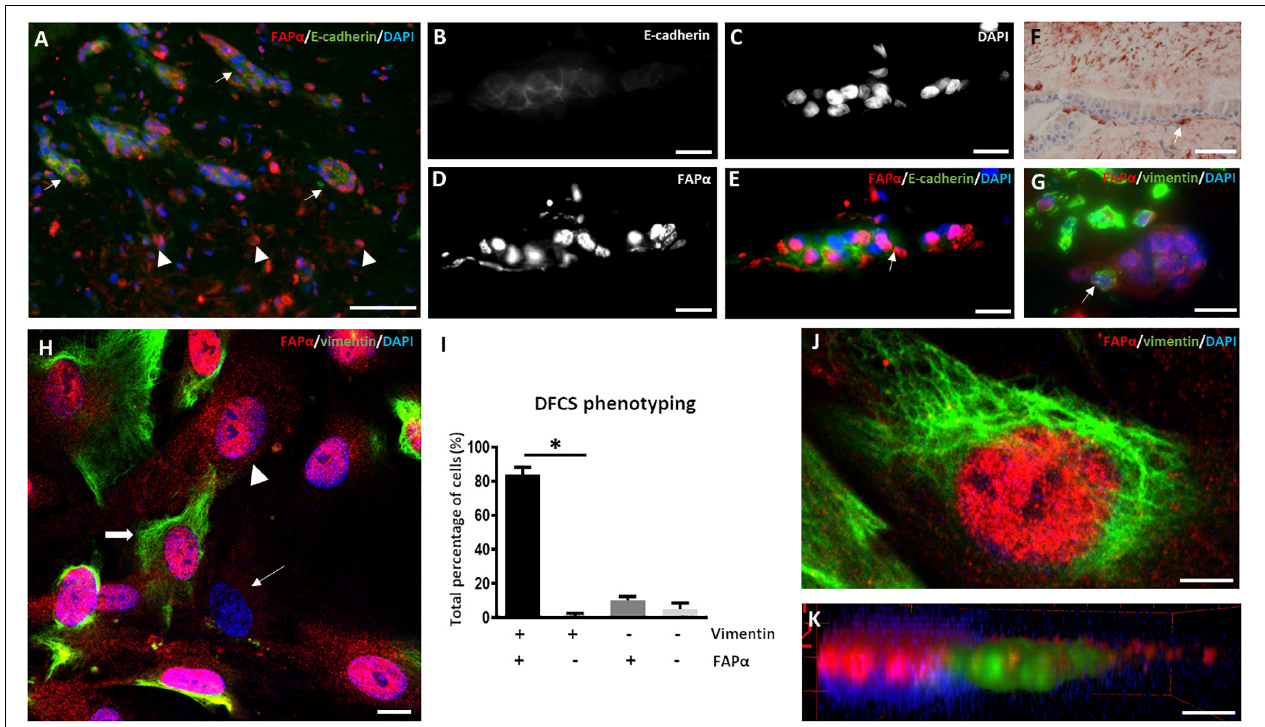
FIGURE 1 | FAP α is expressed in stem cells of the dental follicle. (A) Double immunofluorescent staining in dental follicle tissue of FAP α (red), E-cadherin (green), and the nucleus (DAPI, blue). Arrows indicate epithelial rests and arrowheads point to FAP α + /E-cadherin − cells. (B–E) Higher magnification of an epithelial rest displaying E-cadherin (B) , nuclei (C) , FAP α (D) , and the corresponding overlay (E) . (F) Visualization of mesenchymal cells in the dental follicle using vimentin staining. Note the presence of a vimentin positive cell at the periphery of the epithelial rest (white arrow). (G) Double immunofluorescent staining of FAP α and vimentin showing FAP α + /vimentin − cells in the epithelial rest. A FAP α + /vimentin + cell is located at the periphery of the epithelial rest. (H) Triple immunofluorescent staining of vimentin (green), FAP α (red), and nuclei (blue) in cultured dental follicle stem cells. Indicated cells are FAP α + /vimentin + (thick arrow), FAP α + /vimentin − (arrowhead), and FAP α − /vimentin − (thin arrow). (I) Quantification of the different phenotypes based on vimentin and FAP α expression ( n = 4; ∗ p < 0.05). (J) Confocal image of triple immunofluorescent staining of vimentin (green), FAP α (red), and nuclei (DAPI). (K) 3-D volume rendering of (J) showing localization of FAP α on the plasma membrane. Scale bars represent 4 (J,K) , 10 (B–E,G,H) , and 50 (A,F) µ